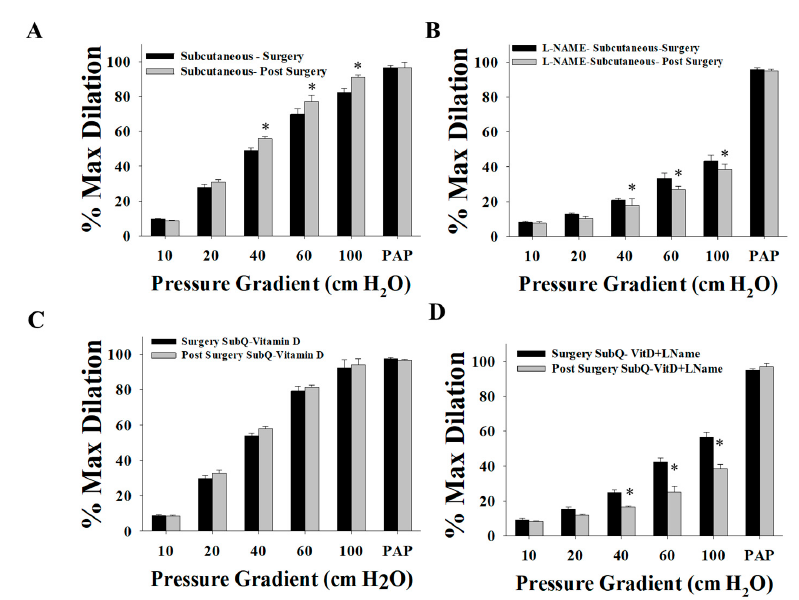
Figure 8. Comparison of the FID between SAT arterioles collected on the day of bariatric surgery and those collected three months after surgery. FID measurements corresponding to intraluminal pressure gradients of 10 – 100 cm H 2 O in SAT arterioles at baseline ( A ) and after incubation with L-NAME ( B ), vitamin D ( C ), and vitamin D plus L-NAME ( D ). All measures are represented as means ± SE; * p < 0.05 comparing post-surgery with surgery-obtained arterioles.